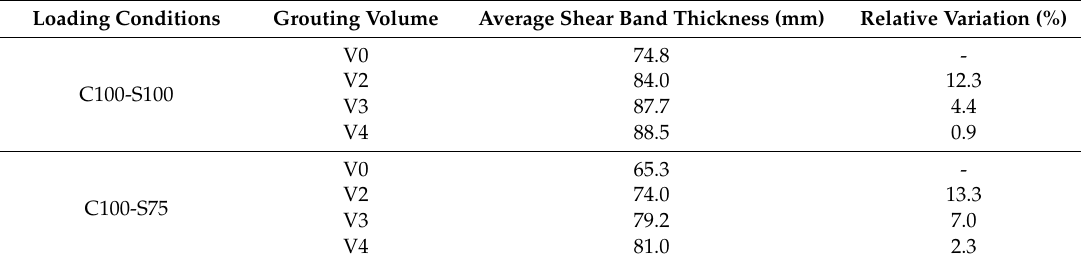
Table 9. Average shear band thickness for specimens with R0 under di ff erent grouting conditions Loading